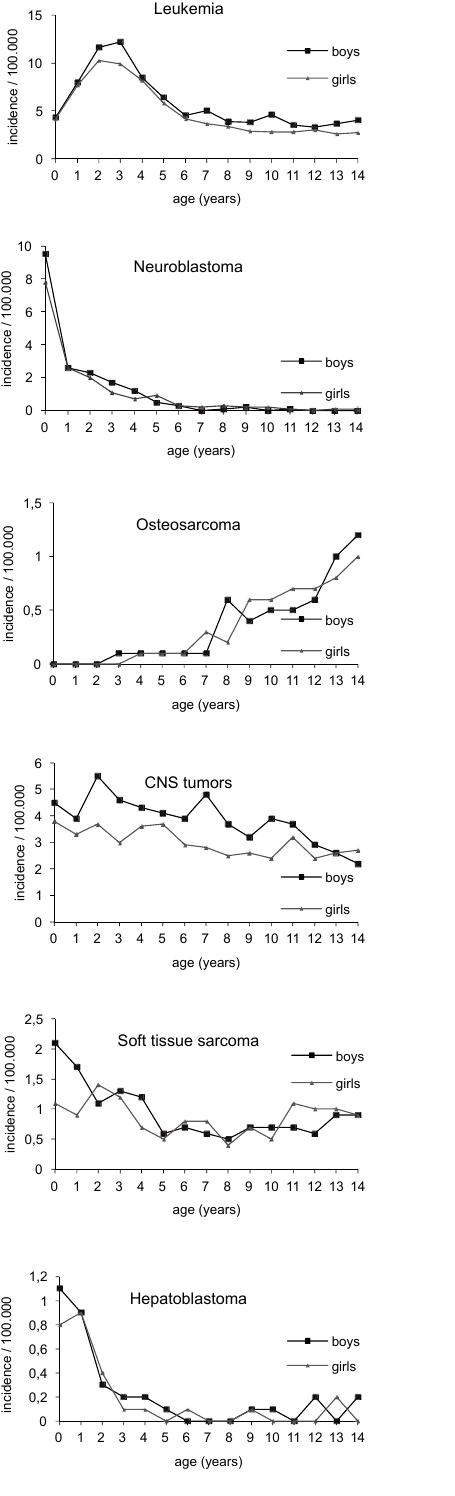
Figure 3. Age and sex-specific incidence rates of the most common childhood cancer diagnoses per 100.000 children less than 15 years in Germany (2003-2007) [ 2